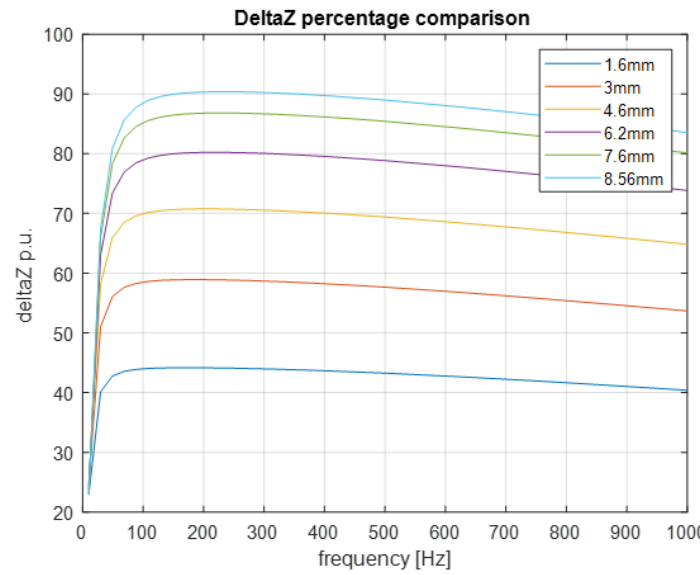
Figure 10. Rectangular slot–impedance comparison.